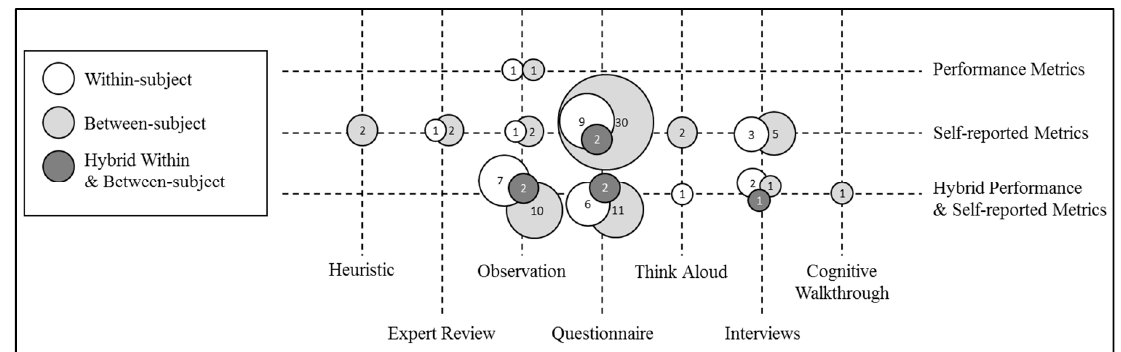
Figure 18. Three-dimensional mapping of common usability techniques with evaluation types and used metrics.